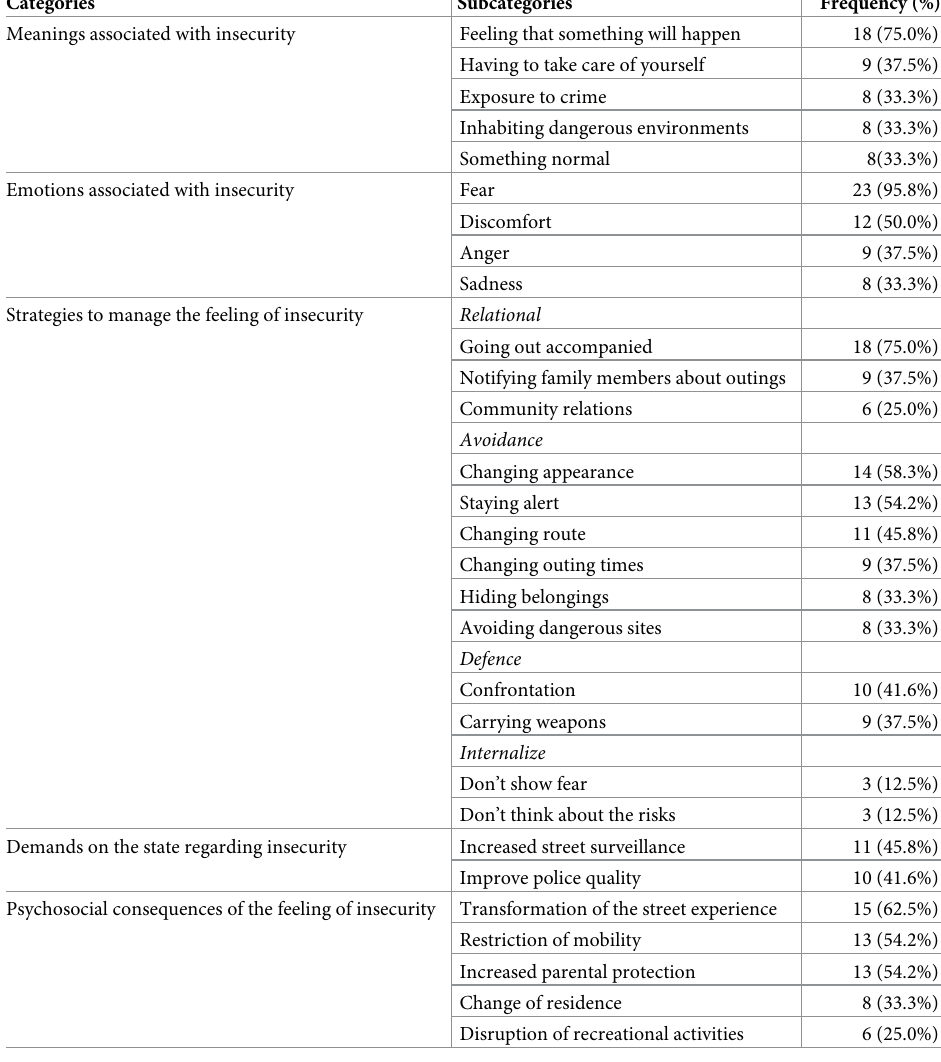
Table 3. Manifestations of feelings of insecurity in public spaces and its psychosocial consequences: Main catego- ries and subcategories across groups (n =